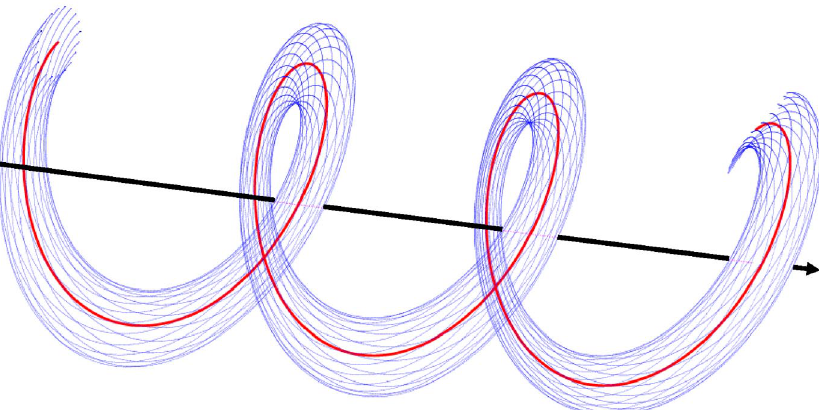
FIG. 6. (Color) Illustration of motion of the beam about the z axis (black), which coincides with the solenoid center. For a given momentum, muons (blue) oscillate about the periodic equilibrium orbit (red). This view in perspective shows 20 muons as they oscillate about the equilibrium orbit for three helix